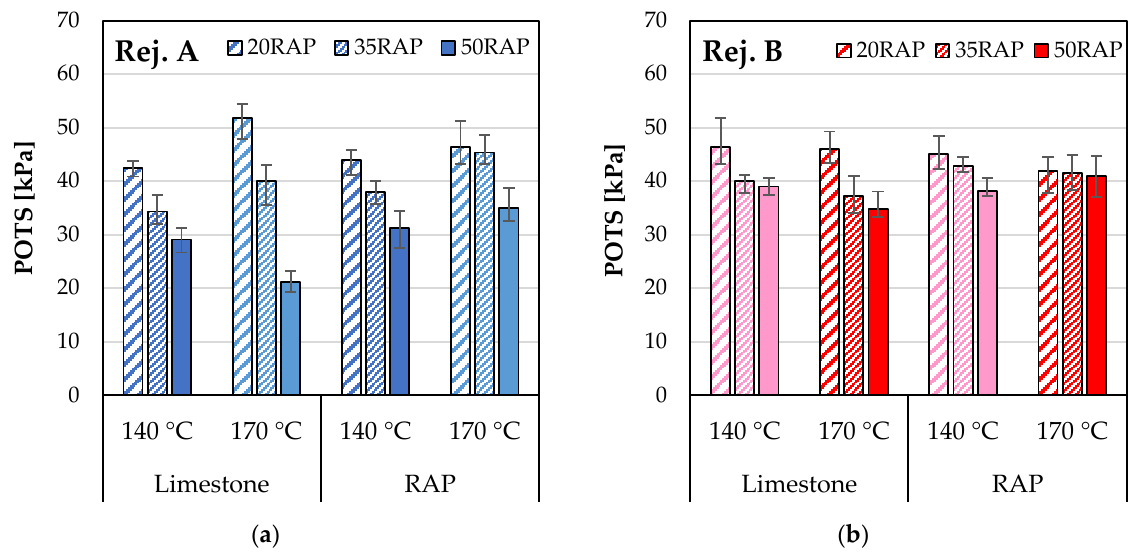
Figure 10. Pull-off tensile strength (POTS) values: ( a ) bituminous blends with rejuvenator A; ( b ) bituminous blends with rejuvenator B.